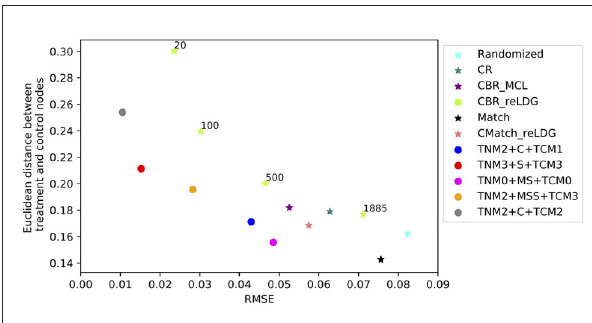
FIGURE10 The tradeoff between selection bias (distance) and undesirable spillover (RMSE) in CMatch MCL variants (labeled with methods applied in) and baselines in the Cora dataset for e.p = edge-weight ; CBR reLDG is annotated with the number of clusters.